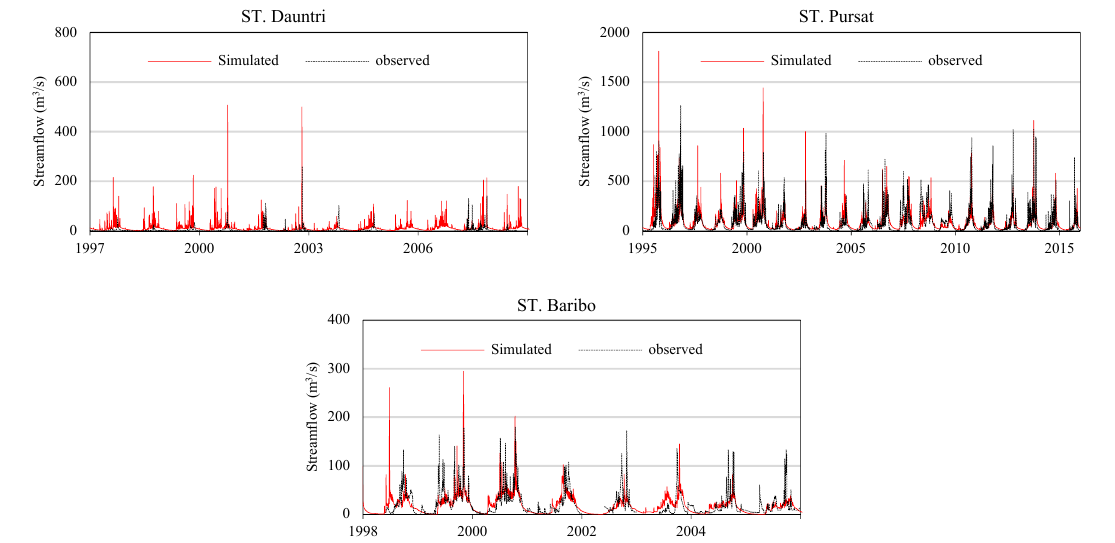
Figure 2. Comparison between daily observed and simulated river flows in 11 sub-basins of Tonle Sap Lake Basin.